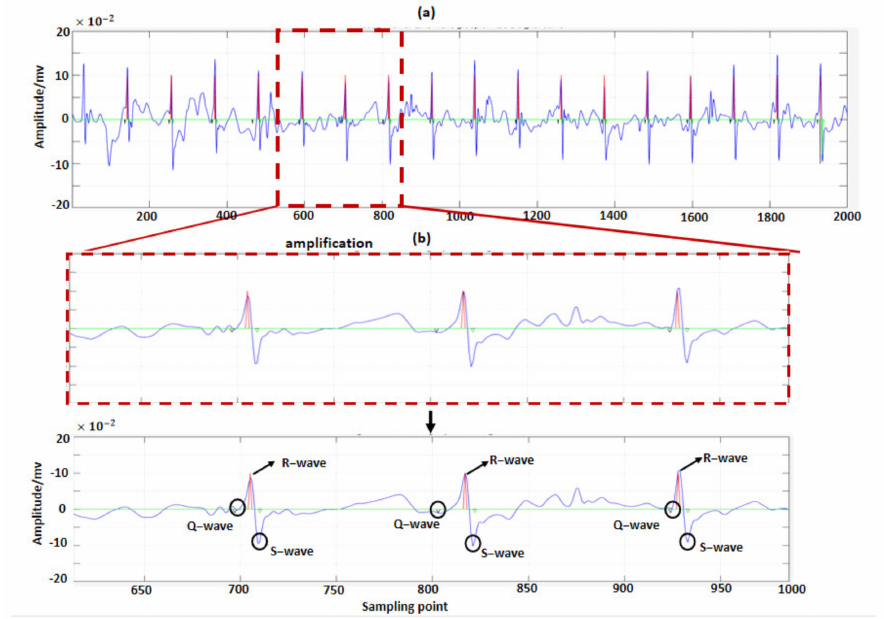
Figure 8. Detection of QRS waves (using R01 data from the ADFECGDB database): ( a ) is the detection results of QRS waves; ( b ) is the amplification marker of ( a